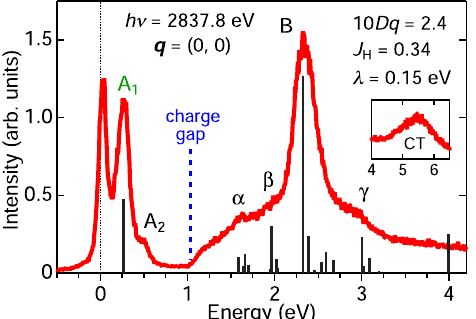
Fig. 2 Determination of microscopic parameters from high-energy multiplets. A representative Ru L 3 RIXS spectrum of RuCl 3 at q = (0, 0), taken with photons of energy 2837.8 eV. The dashed blue line indicates the onset energy of the intersite electron-hole continuum. The vertical black bars indicate the theoretical RIXS intensity from ionic multiplet calculations (Supplementary Note 2). The cubic crystal fi eld splitting (10 Dq ), the Hund ’ s coupling ( J H ), and the spin-orbit coupling ( λ ) parameters obtained from an analysis of the RIXS spectrum are indicated. The inset shows the high- energy region comprising the p - d charge-transfer (CT) excitations.